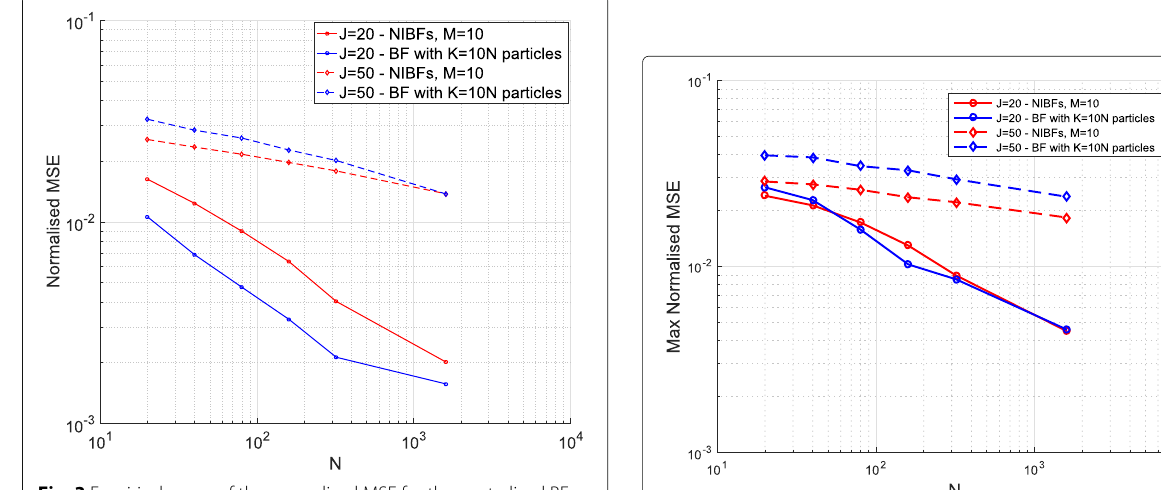
Fig. 3 Empirical mean of the normalised MSE for the centralised BF, with K = 10 N particles, and the average of M = 10 NIBFs with N = 20,40,80,160,320,1600. Results are shown for a Lorenz 96 system with J = 20 variables (solid lines) and a Lorenz 96 model with J = 50 variables (dashed lines). All curves have been obtained from a set of 100 independent simulation trials